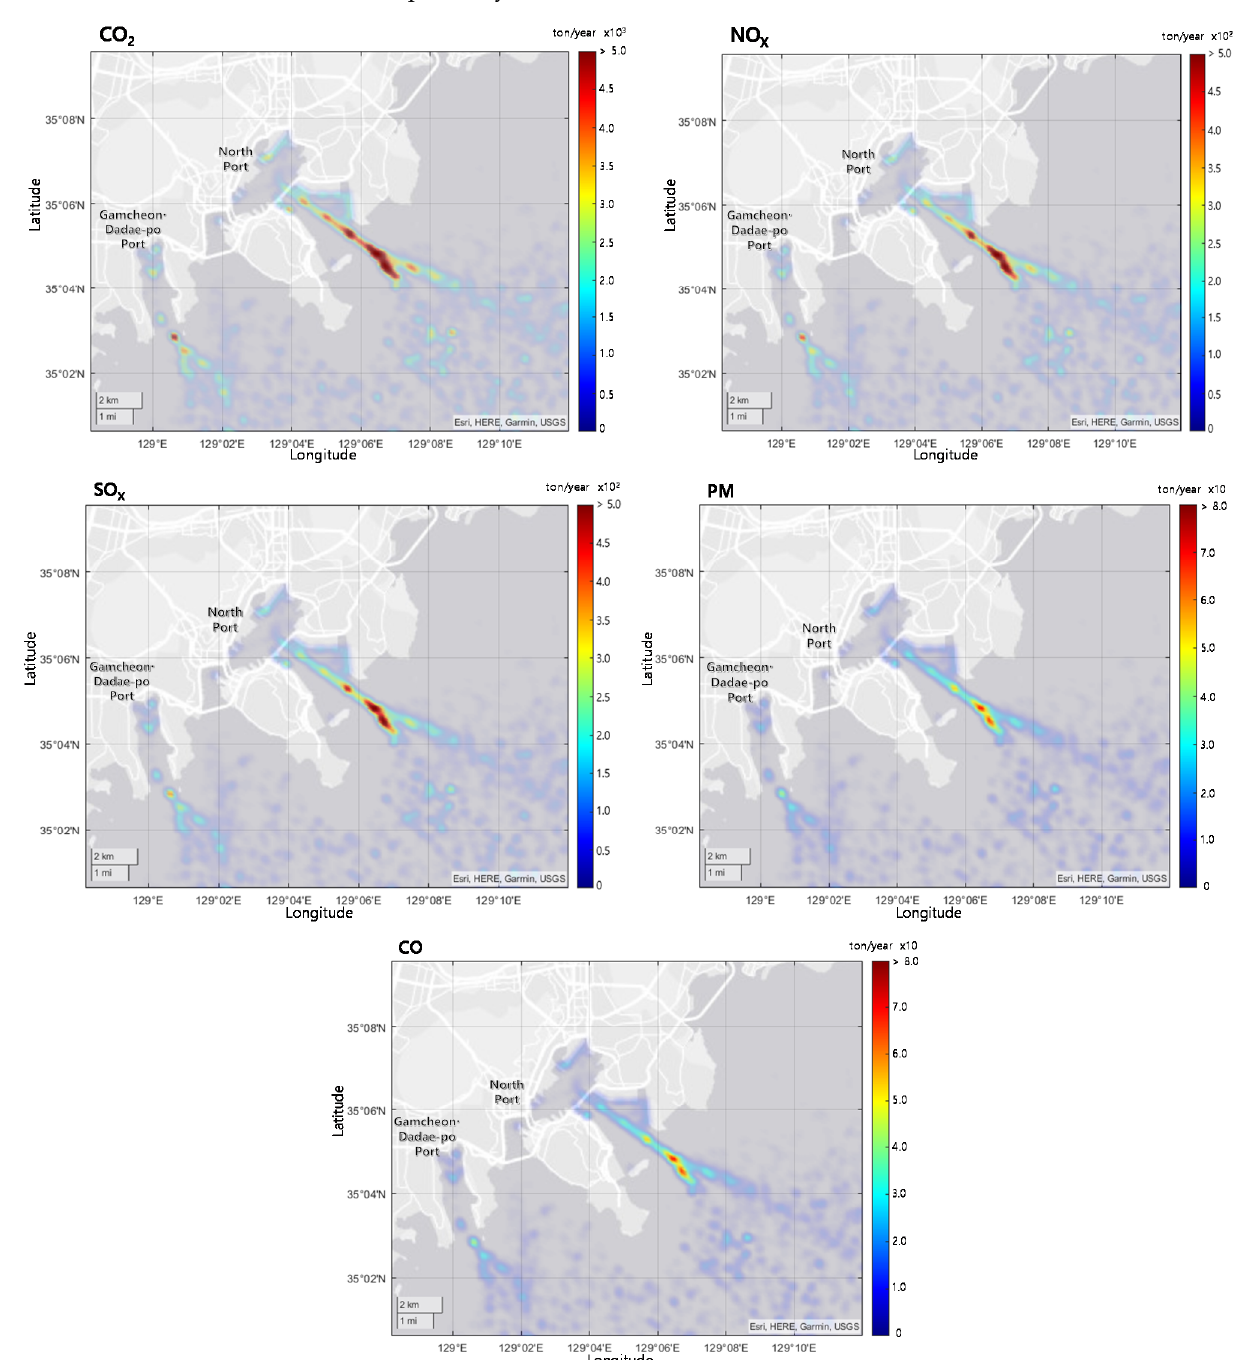
Figure 7. Spatial distribution of CO 2 , CO, NO X , SO X and PM in BP in 2019.